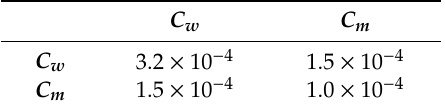
Table 5. Covariance matrix of C w and C m parameters used for LUT generation in strategy 3.